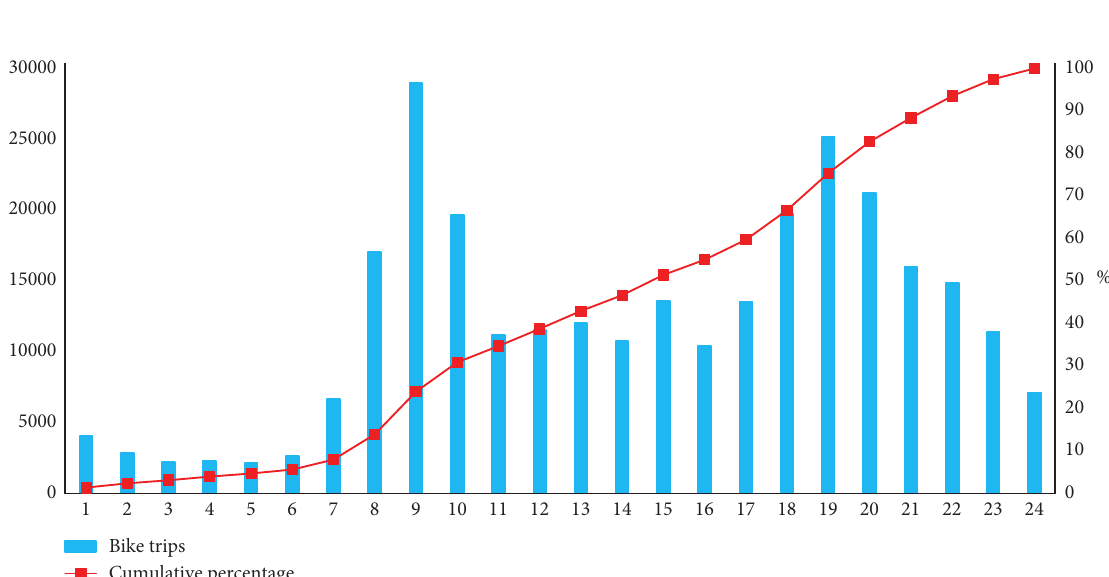
Figure 3: Floating bicycle riding trips’ distribution across time within one day (24